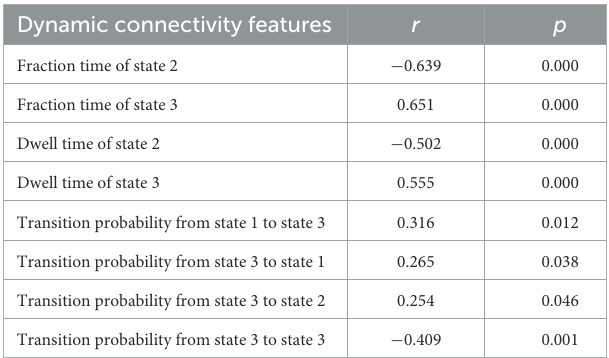
TABLE 2 Dynamic state features correlated with